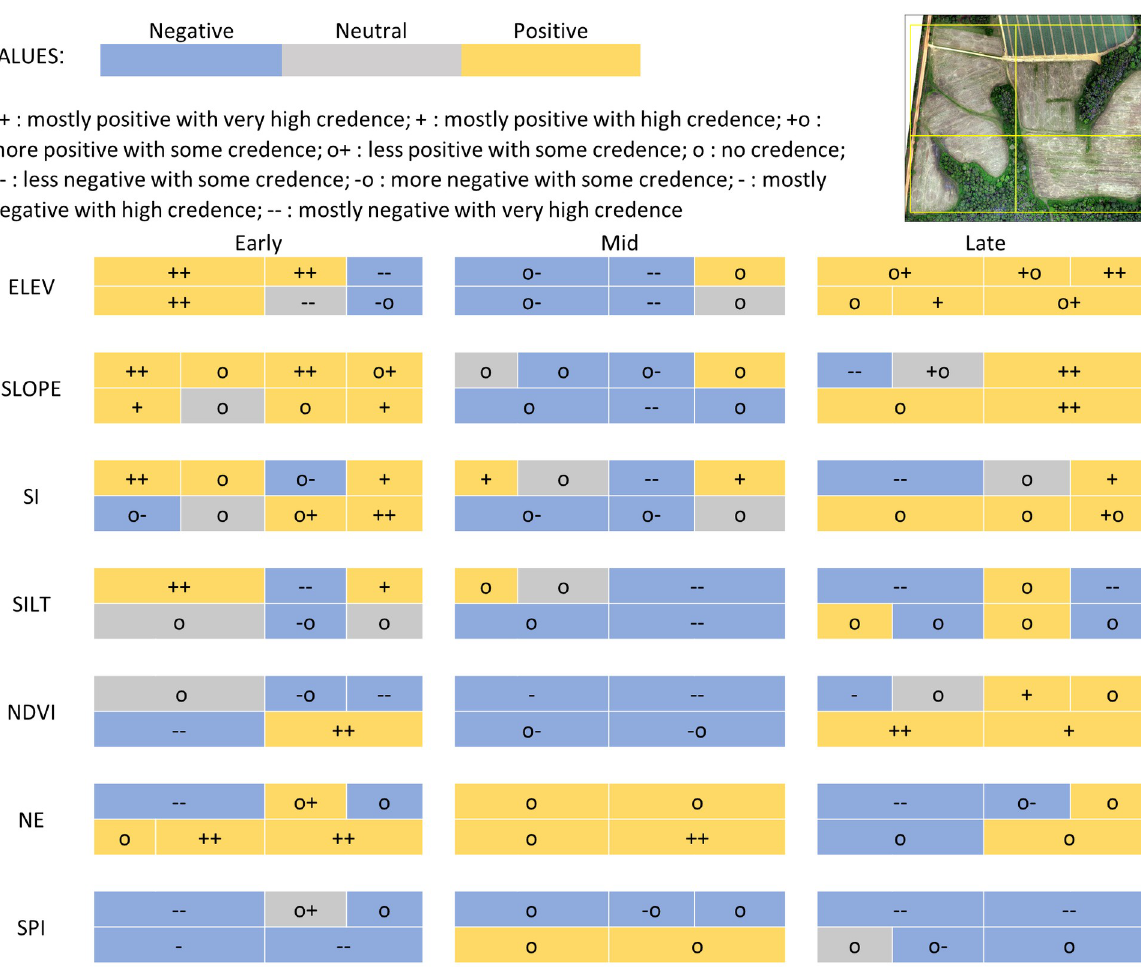
Fig 4. Heat map of geographically weighted regression (GWR) coefficient signs as related to map surfaces across fields. Early, Mid and Late columns refer to sample dates. Rows refer to explanatory variables. Columns are divided into four quadrants corresponding roughly to four regions of the fields as shown in the inset map. In some cases, a quadrant is further subdivided, but this is only to indicate that there was no single positive trend across that